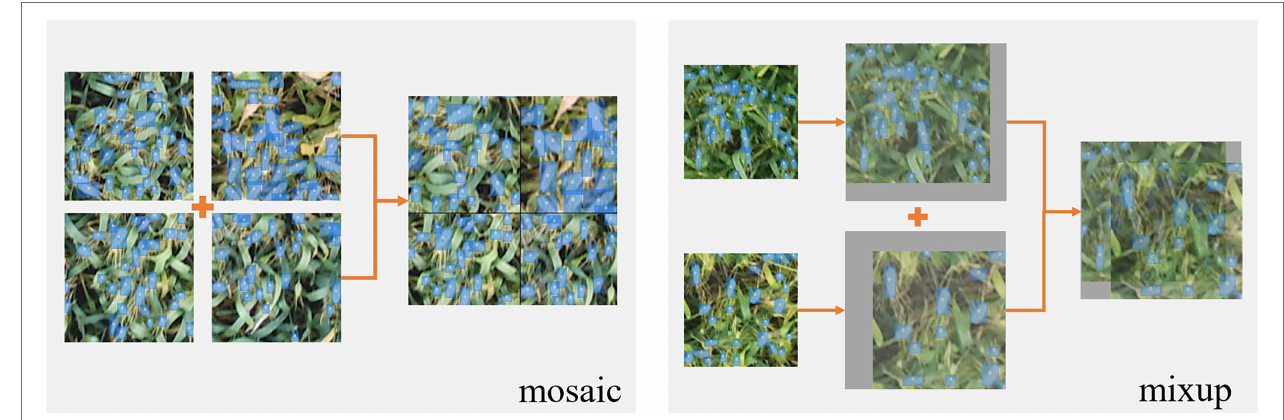
FIGURE 5 | Schematic diagram of mosaic and mixup